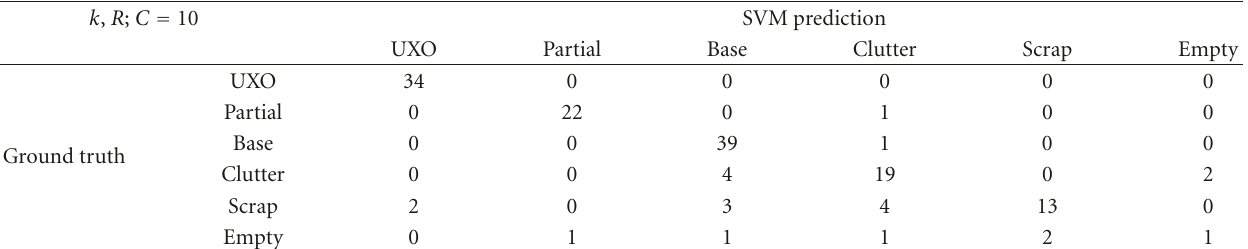
Table 1: SVM classification of Camp Sibert anomalies using k and R with C = 10.